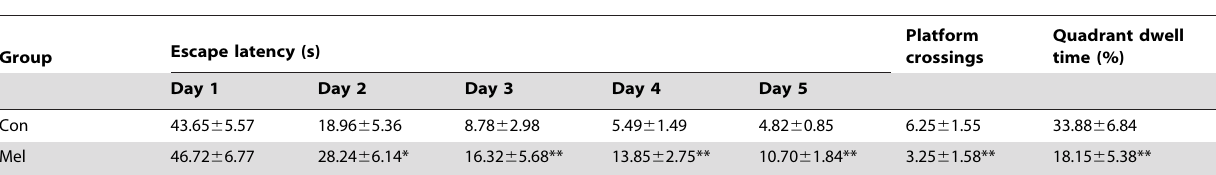
Table 1. The results of MWM.